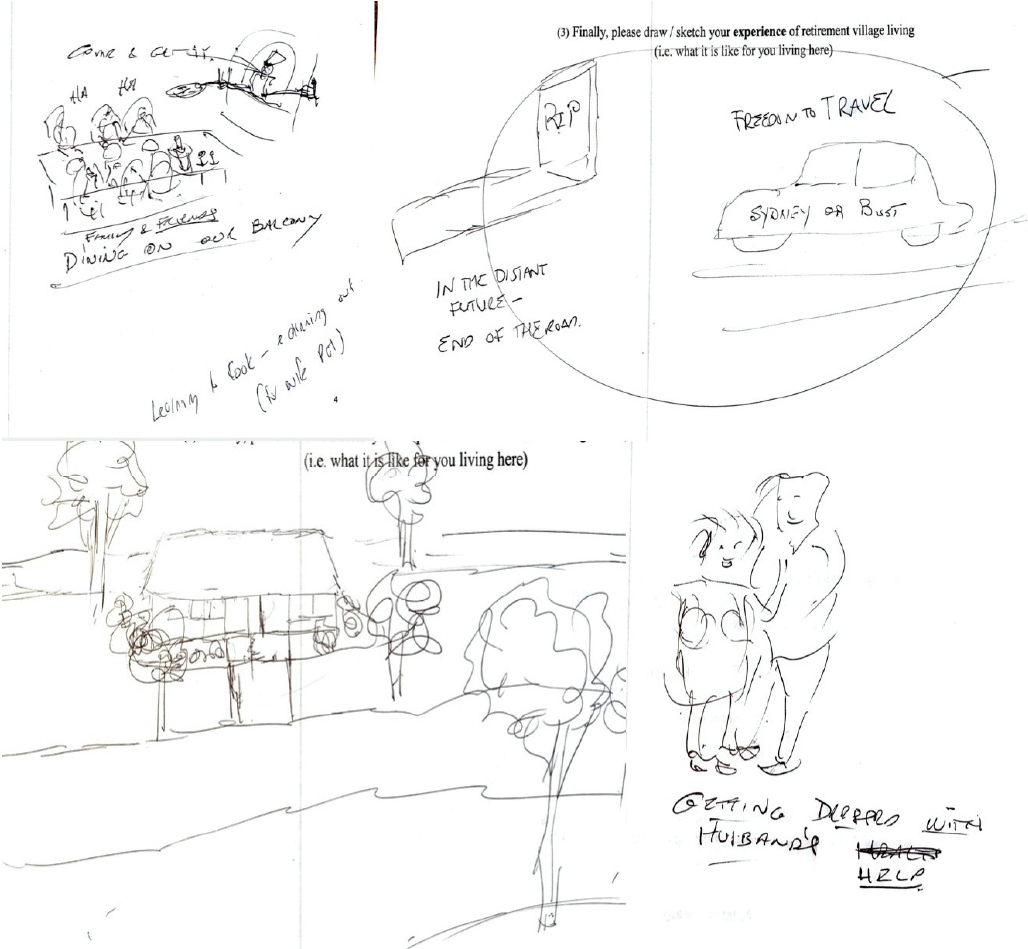
Figure 7. Experiences of retirement village life—enjoying freedom until death.